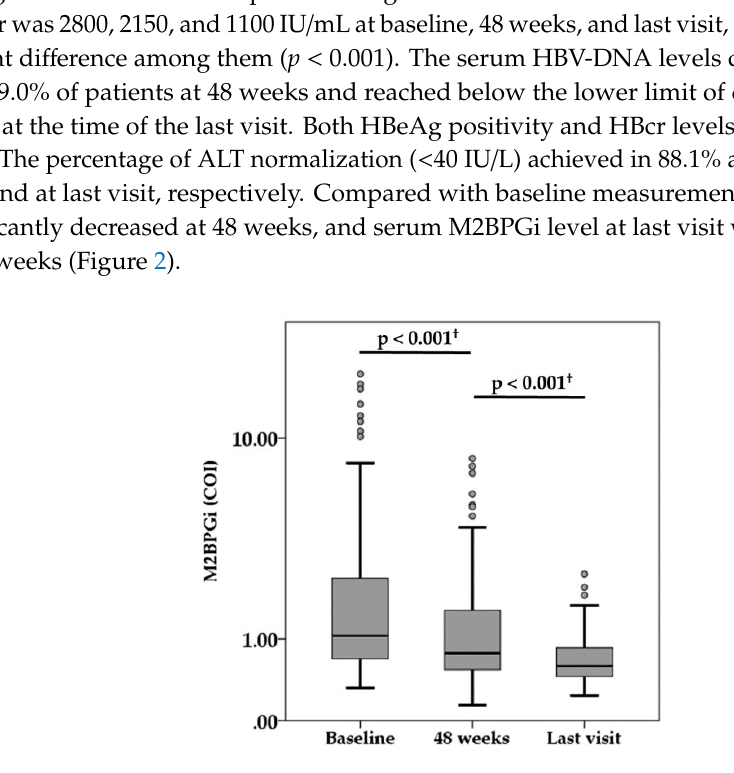
Figure 2. Serum levels of Mac-2-binding protein glycosylation isomer (M2BPGi) during nucleot(s)ide analogue therapy. † Wilcoxon signed rank test. COI, cut-off index.